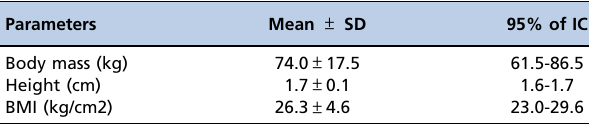
Table 1 - Anthropometric characteristics.